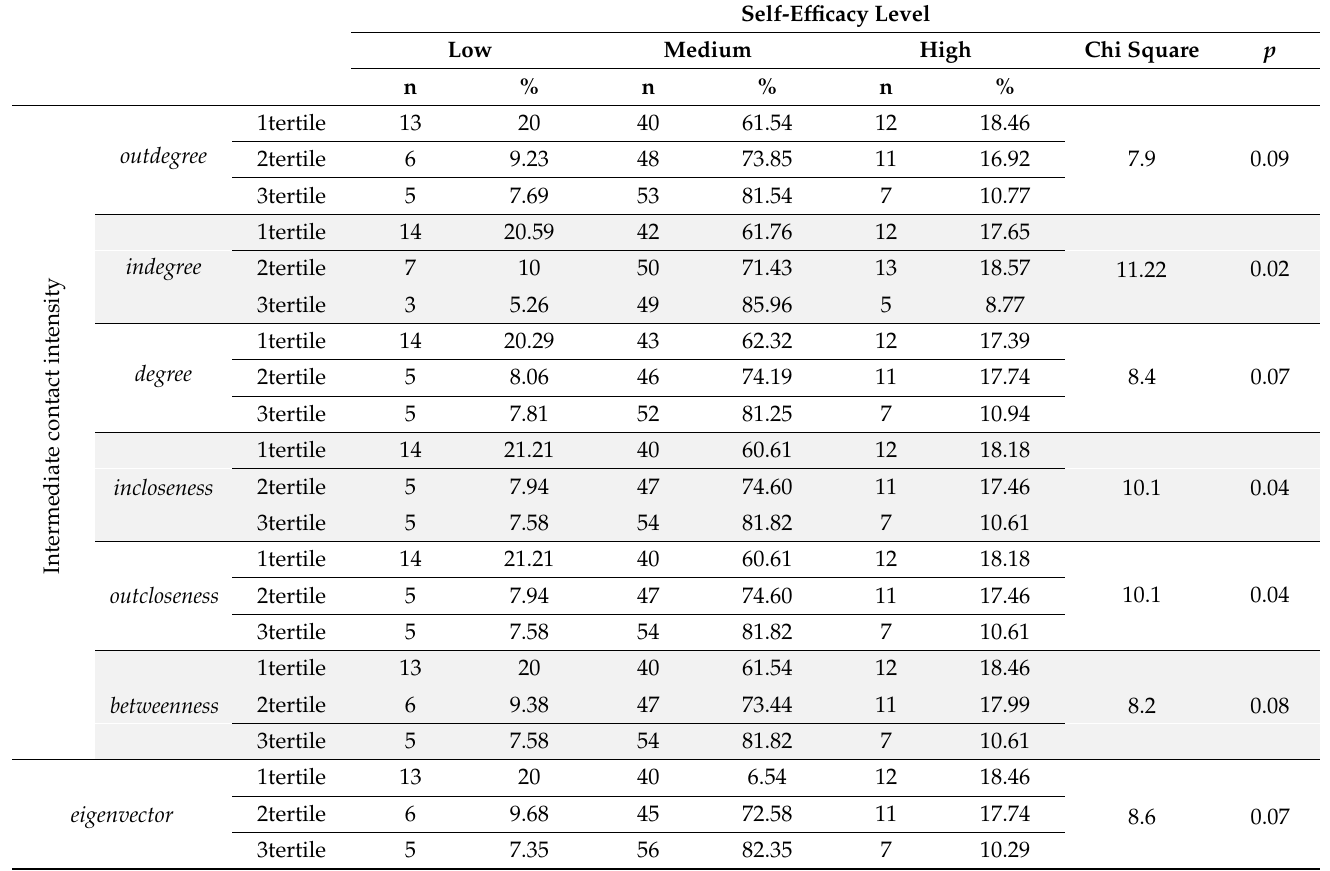
Table 3. Centrality indicators in relation to self-efficacy. (In Intermediate contact